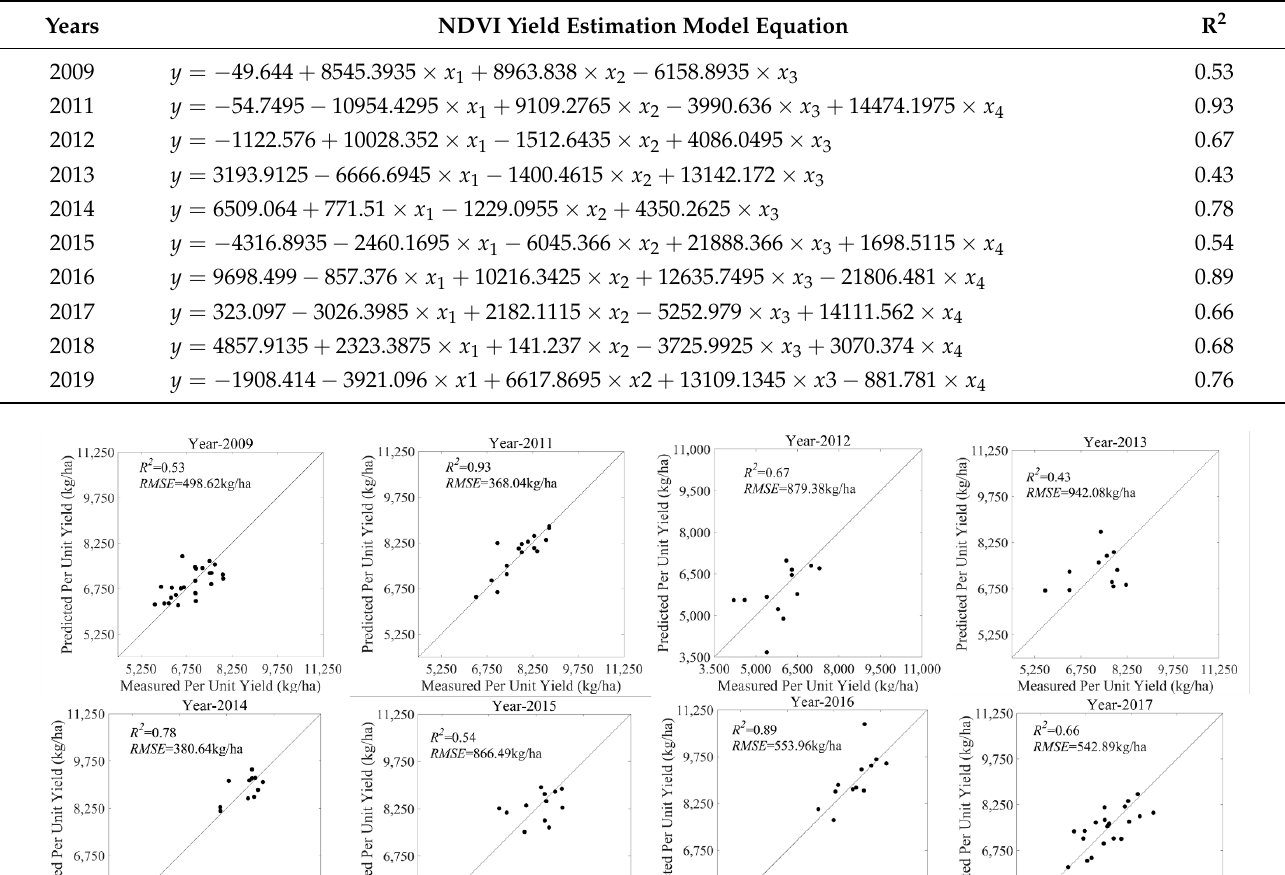
Table 3. Yield estimation model based on long time series.